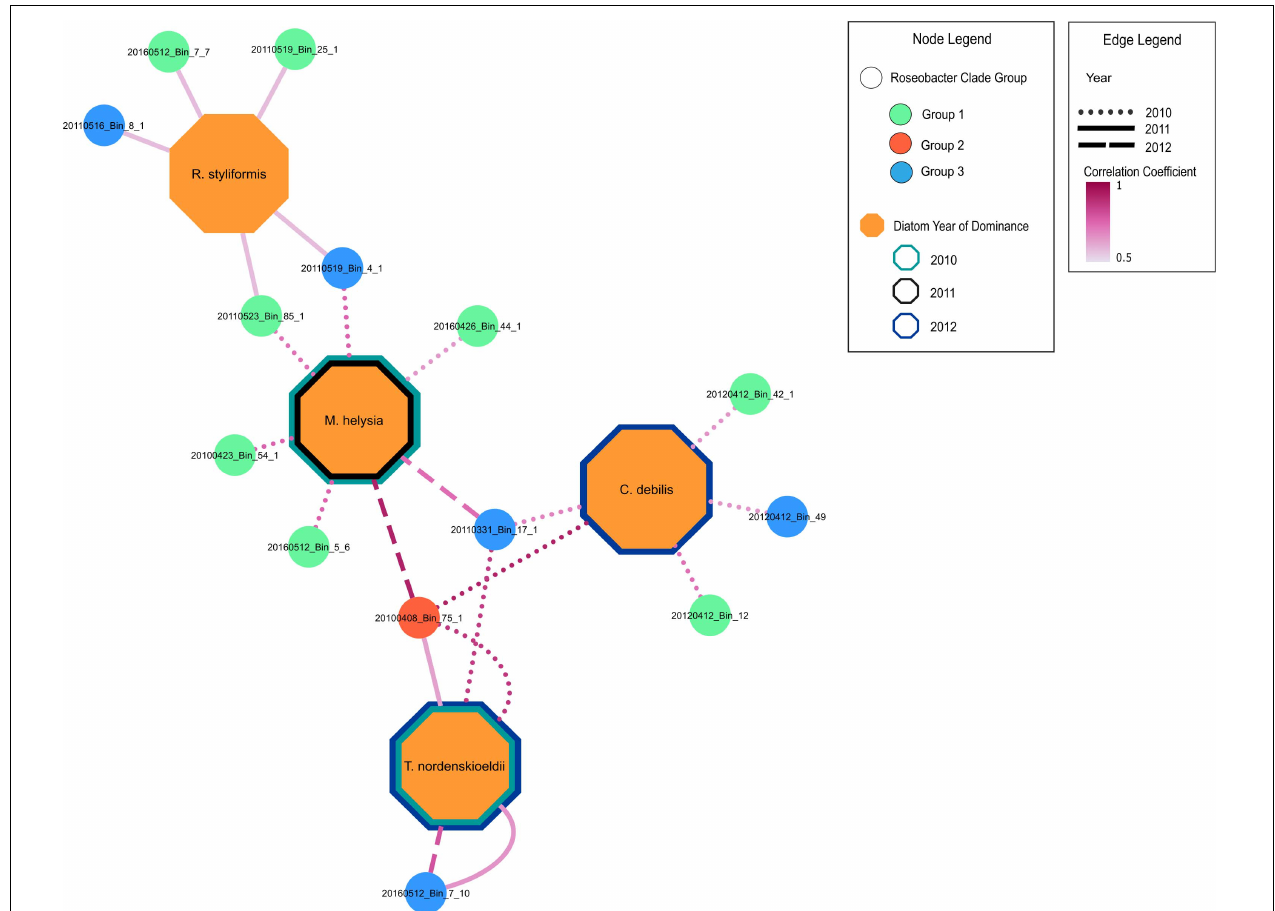
FIGURE 5 | Positive correlation relationships of MAGs with dominant diatom species during blooms across 2010-2012. MAGs nodes are color coded according to groups in Figure 3 . Only significant ( p < 0.05) positive Spearman rank correlation coefficients between MAGs and significant diatoms (from RDA analysis) are shown ( Supplementary Table 5 ). Border color of diatom nodes indicates the year of dominance. Diatoms were considered dominant if they had the highest diatom cell count during bloom peaks. The 2010 bloom was bimodal with Thalassiosira nordenskioeldii and Mediopyxis helsia peaking at different times. The 2012 phytoplankton bloom was dominated by a silicoflagellate, yet Thalassiosira nordenskioeldii and Chaetoceros debilis were still present, had very similar cell counts and were thus both considered the dominating diatom species. Edge line type indicates the year in which a positive relationship is present between a MAG and a diatom species. The edge line shading indicates the strength of the